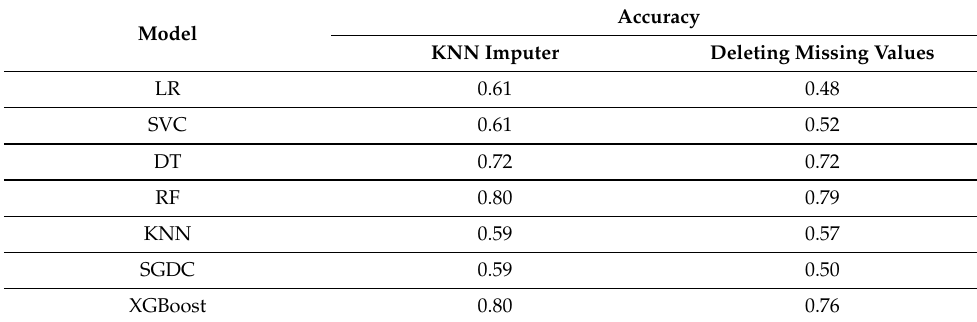
Table 6. Accuracy comparison of the machine learning models.